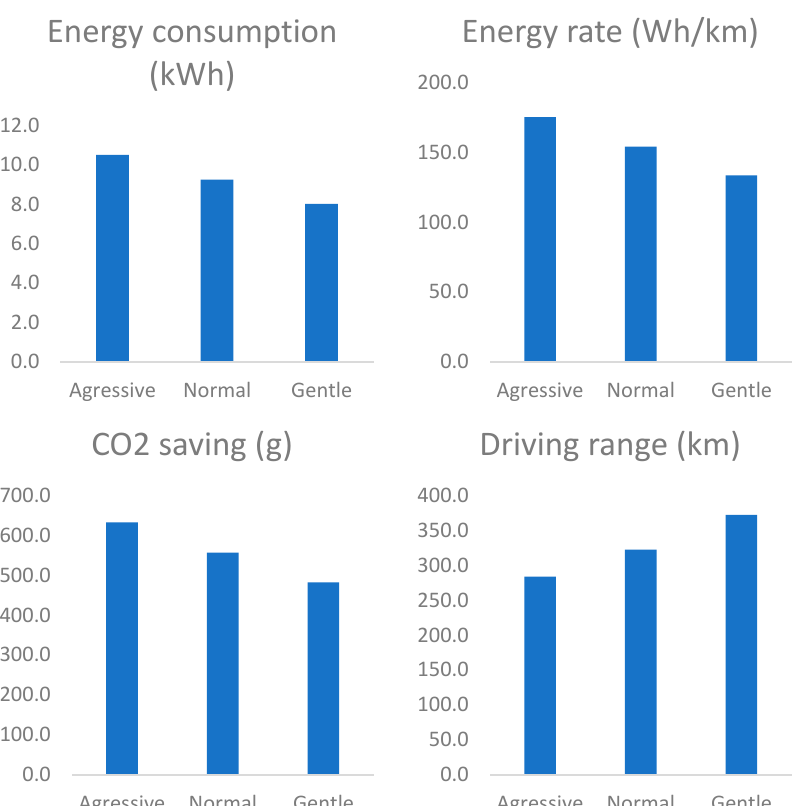
Figure 8. Numerical results of the simulation process